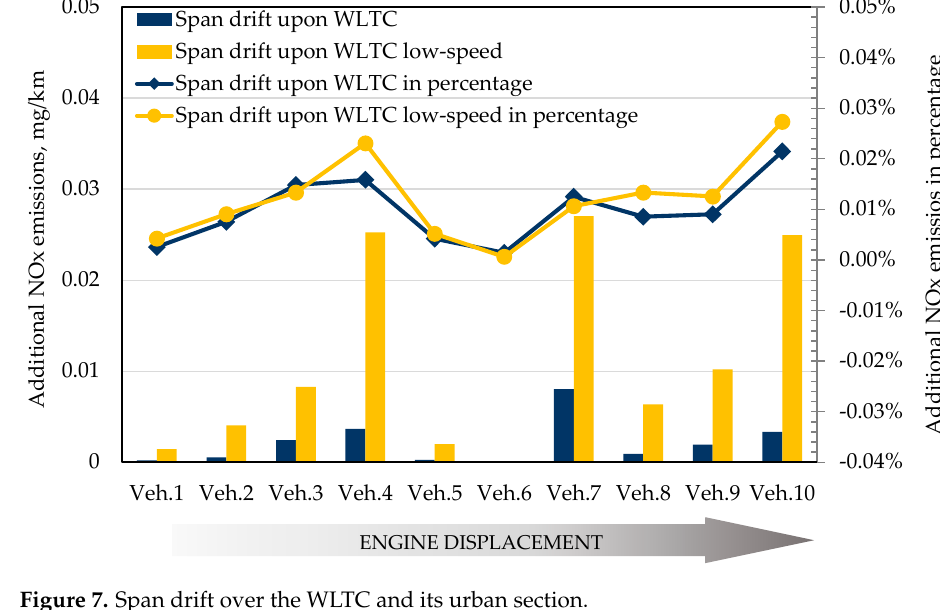
Figure 7. Span drift over the WLTC and its urban section.